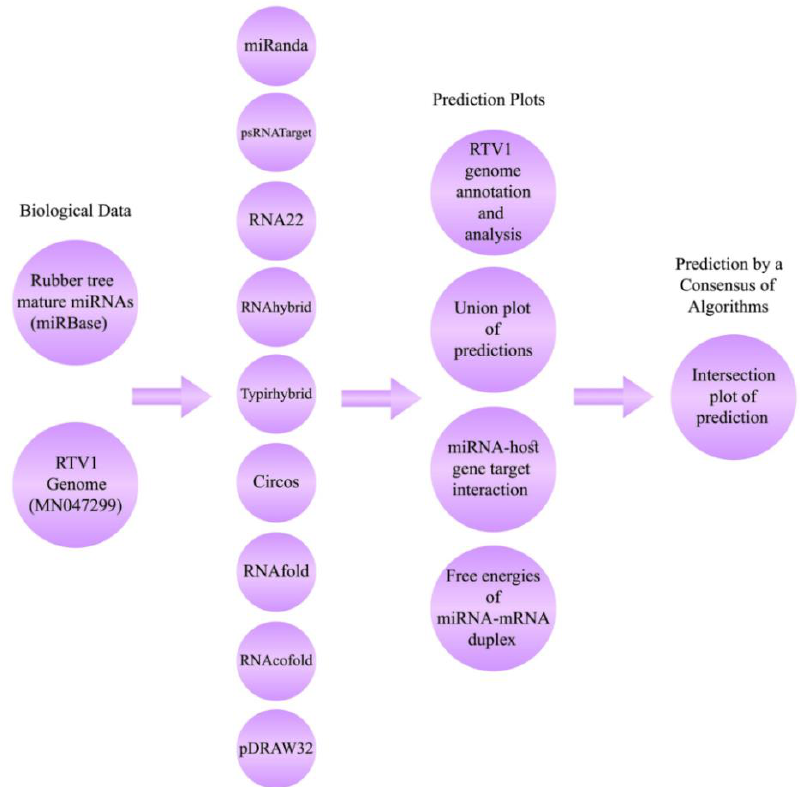
6 rubber tree miRNAs targeting 8 loci. RNAhybrid: 29 rubber tree miRNAs targeting 29 loci. Tapirhybrid has predicted that 5 rubber tree miRNAs targeted 5 loci. psRNATarget: 14 rubber tree miRNAs targeting 23 loci (Figure 3) (Table S3).